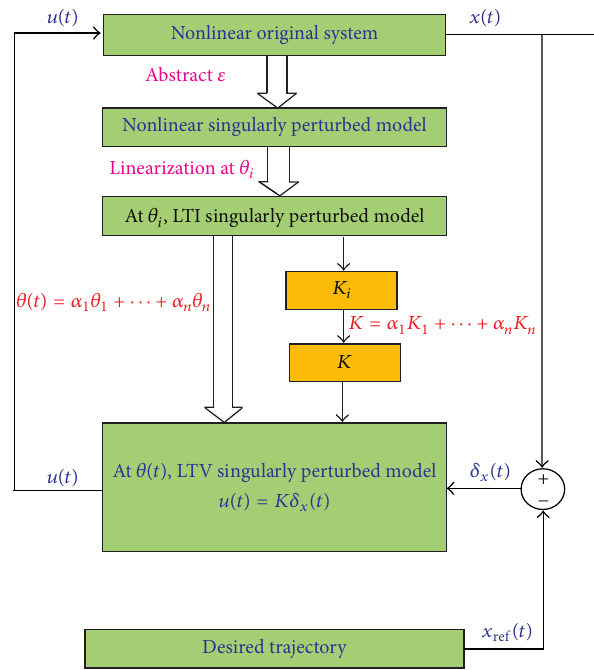
Figure 1: Control configuration of wind turbine